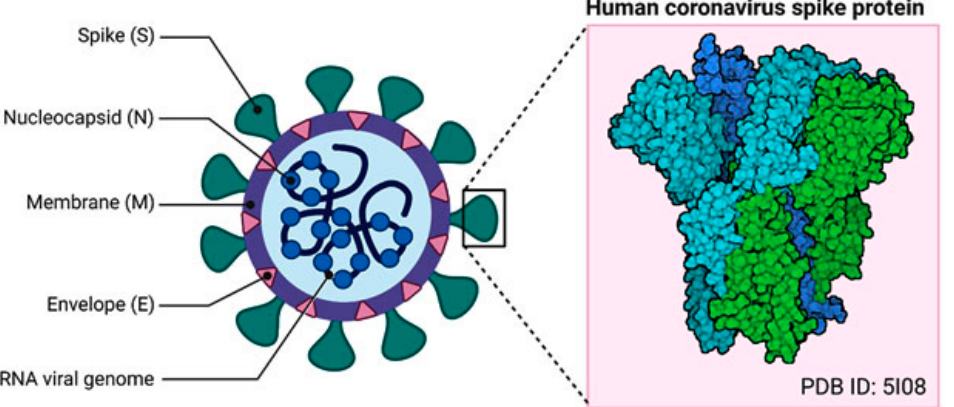
Fig. 2. The 2019-nCoV structure and its protein visualization for active vaccine development. Coronaviruses belong in the family Coronaviridae and can cause disease in mammals and birds. The coronavirus spike (S) protein mediates membrane fusion by binding to cellular receptors. The ¬Figure was created with “BioRender. com” template and exported under the terms of premium